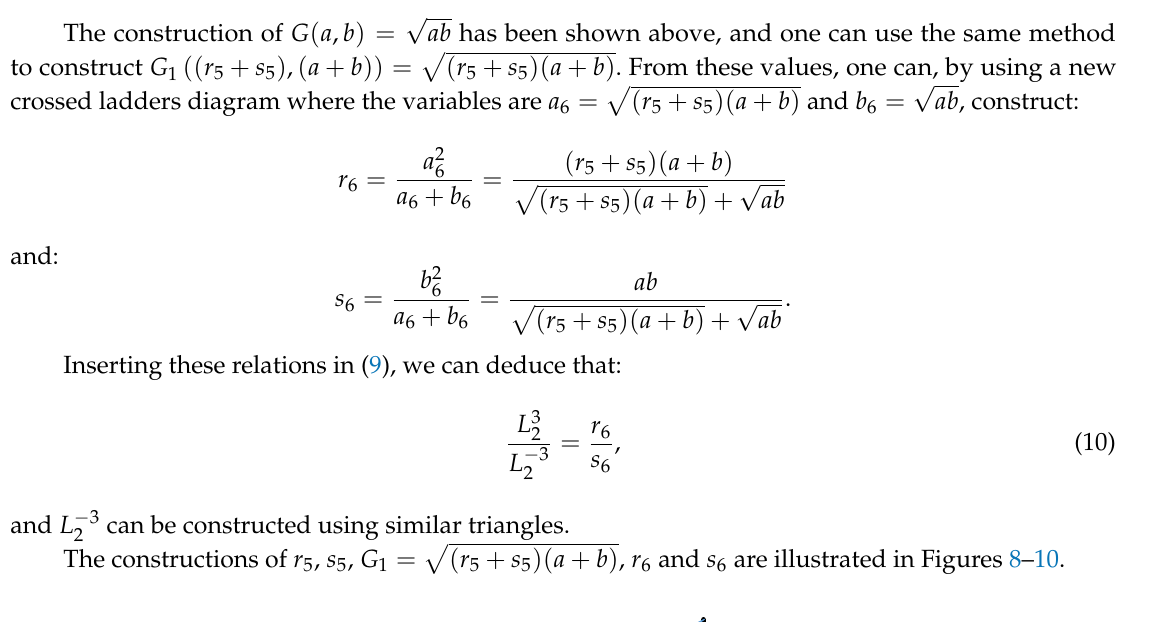
, s 5 = b 4 and ( r 5 + s 5 ) from r = a 2 ( a + b )( a 2 + b 2 ) ( a + b )( a 2 + b 2 )